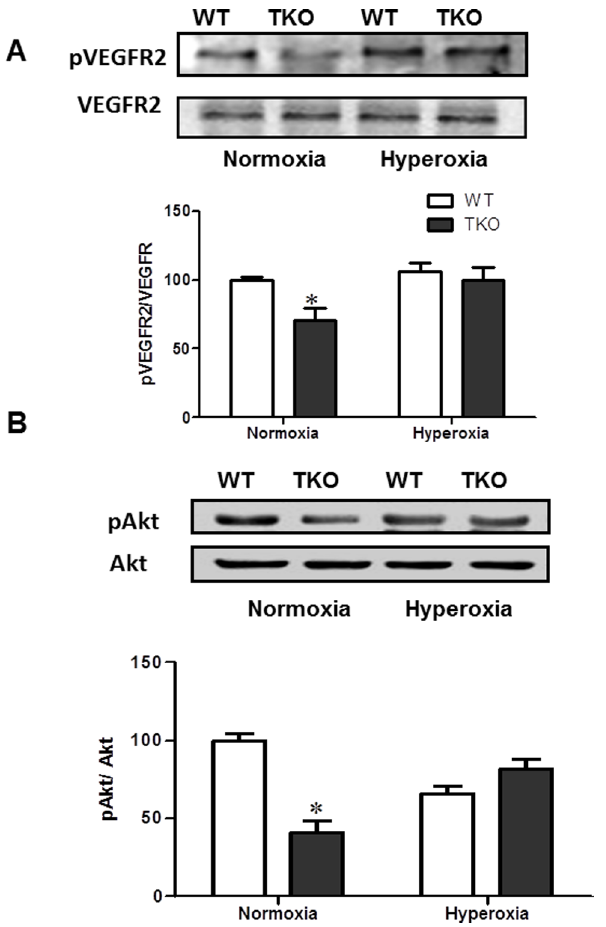
Figure 4. Deletion of TXNIP does not alter VEGFR2/Akt activation under hyperoxia. Wild type (WT) and TXNIP knockout (TKO) mice were subjected to hyperoxia (75% O2, p7–p12). Activation of VEGFR2 ( A ) and Akt ( B ) were examined as downstream signal of VEGF in p12 WT and TKO retinas. TKO showed significant decrease in phosphorylation of VEGFR-2 and Akt compared to WT under normoxic condition. We did not detect significant change in the activation of VEGFR2 and its downstream Akt in retinas from TKO and WT in response to hyperoxia. (*P , 0.05, TKO vs WT, n=4–6).